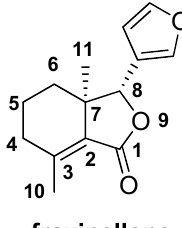
Figure 1. The chemical structure of